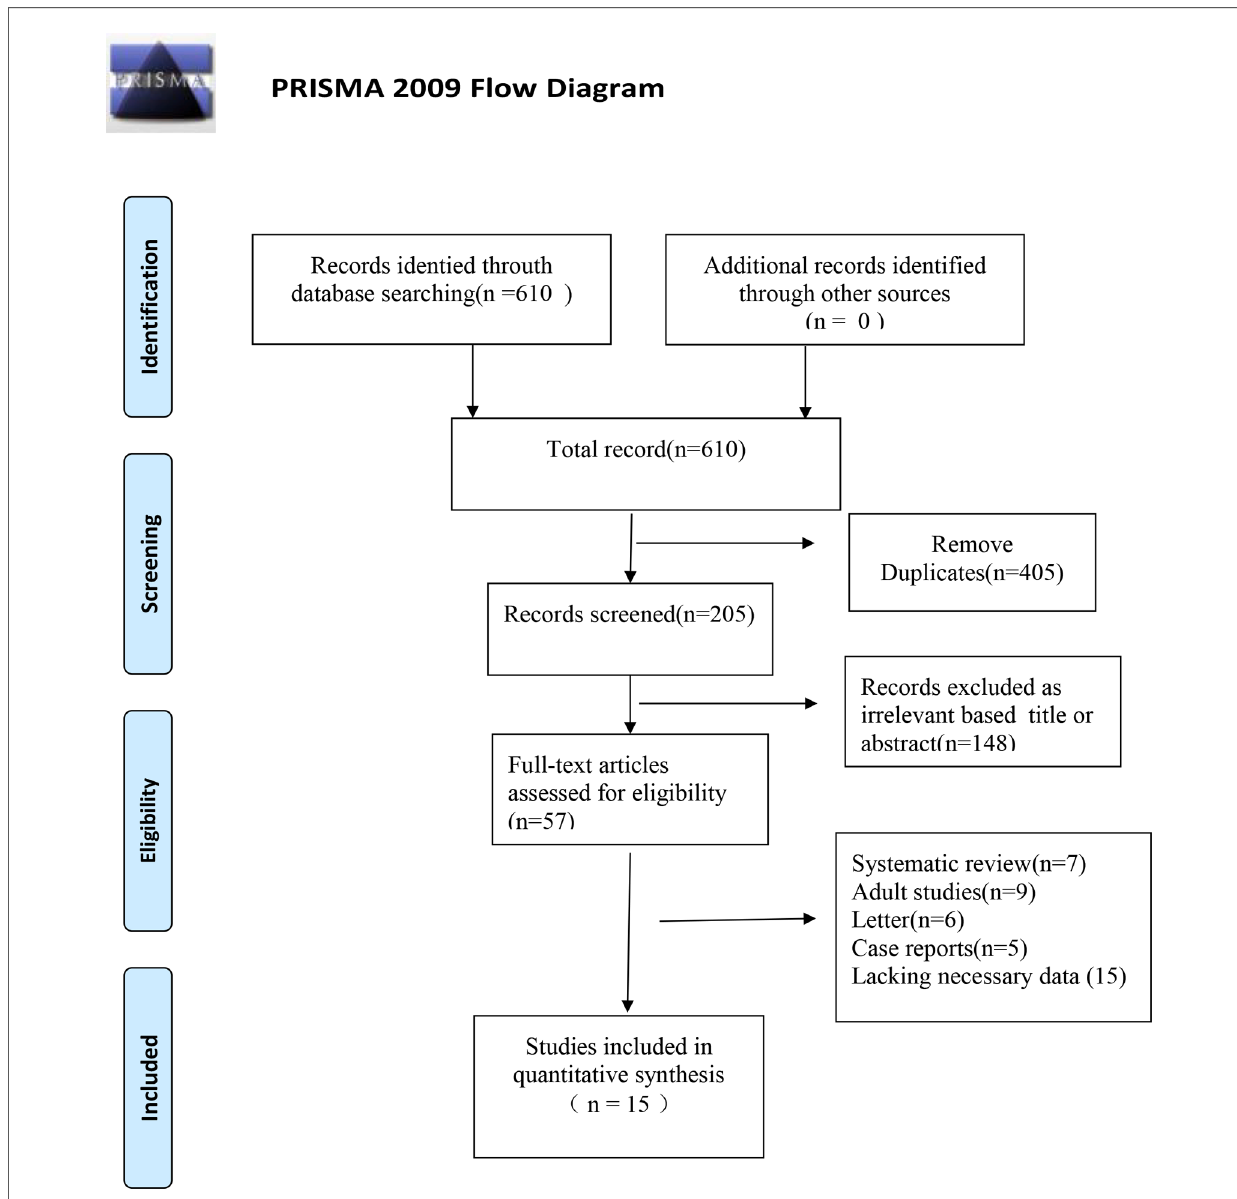
FIGURE 1 Flow diagram for identi fi cation of selected studies in the